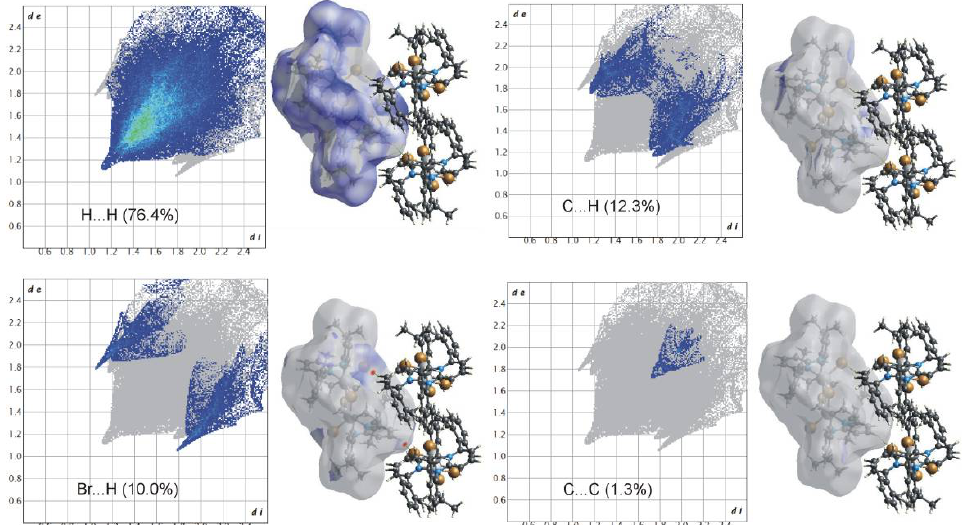
Figure 4. Two-dimensional fingerprint plots for all intermolecular contacts in 1 . The percentage of contribution is specified for each contact.